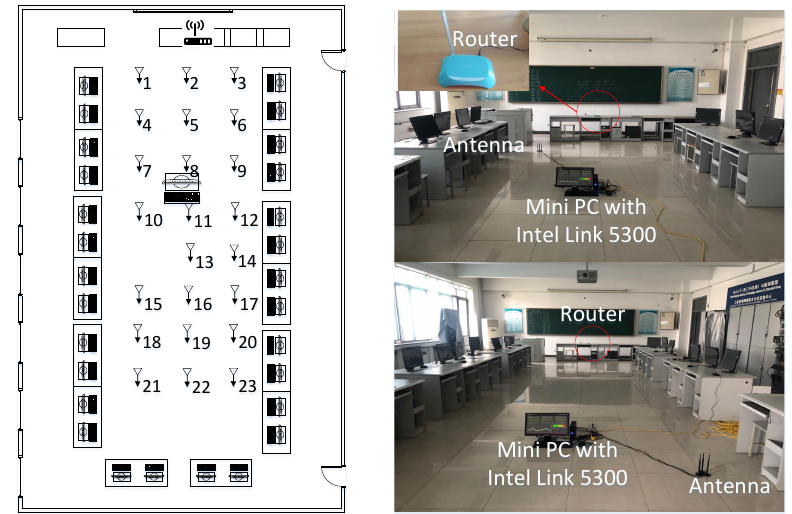
Figure 15. Experiment scene and planar graph of the laboratory.